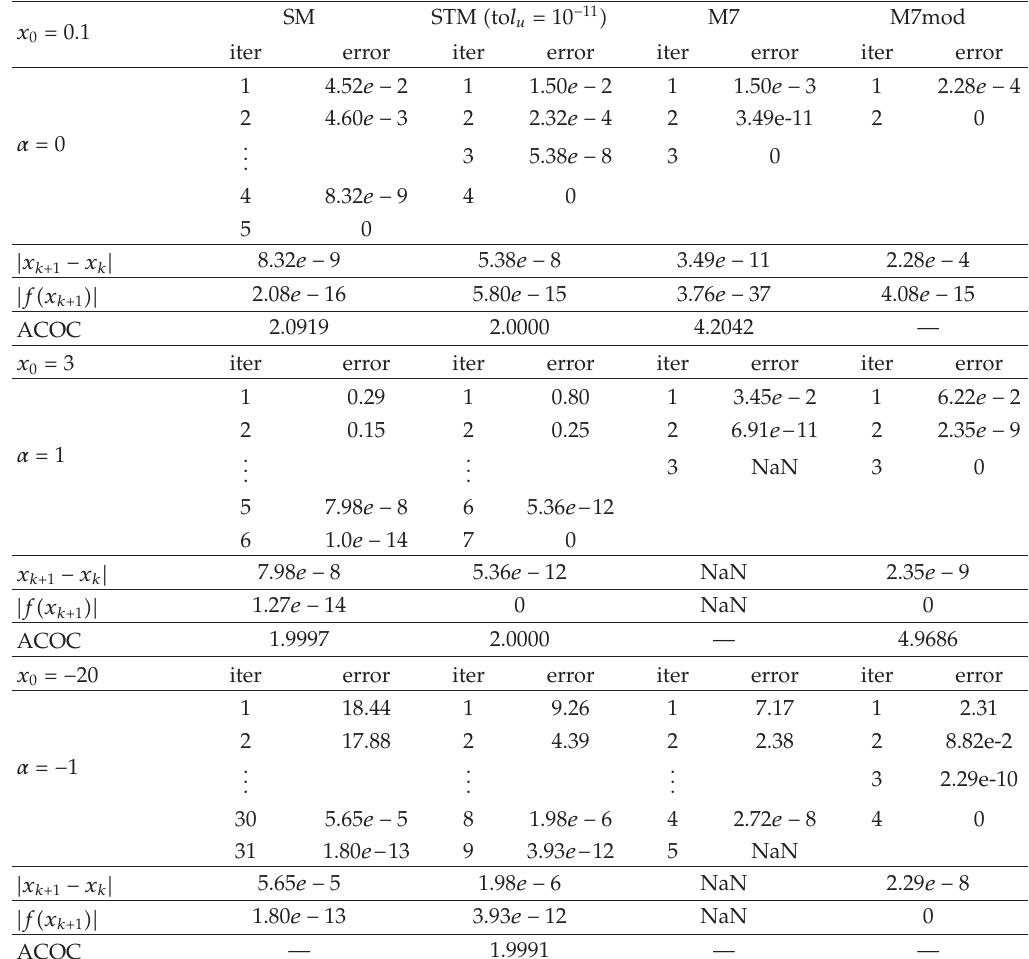
(cid:4) x (cid:5) 11